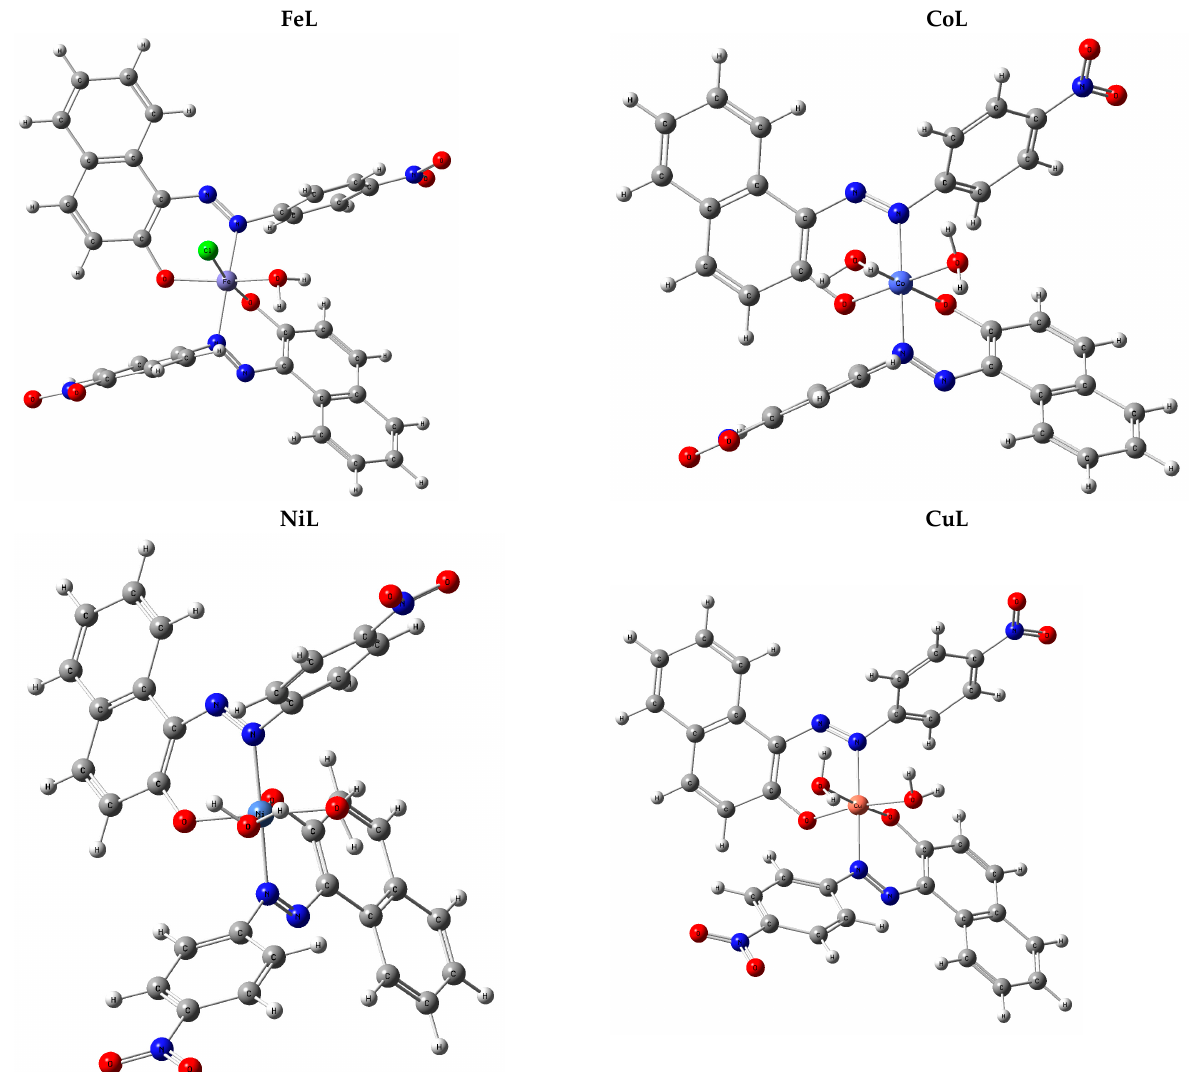
Figure 2. 3D optimized structure of the compounds.